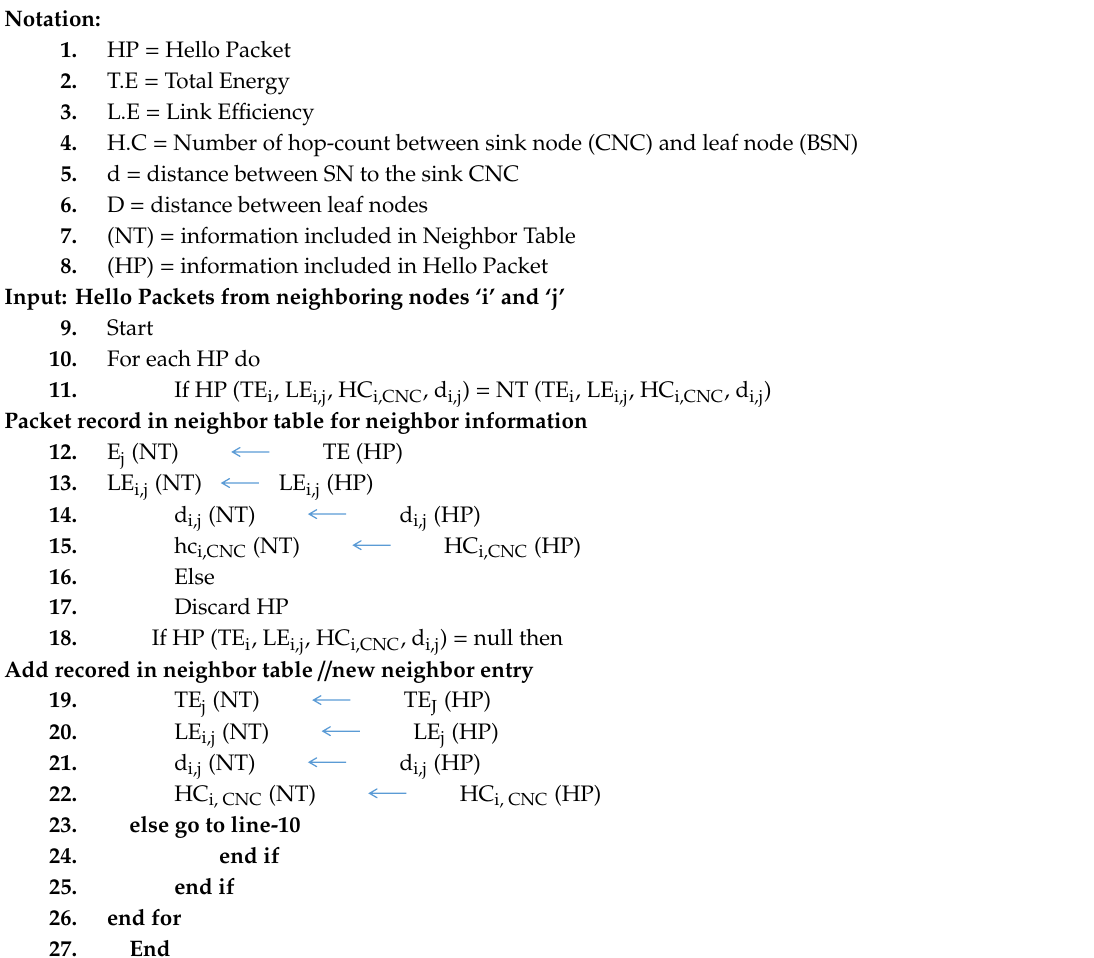
Algorithm 1: Data sensing and Topology discovery phase Notation: